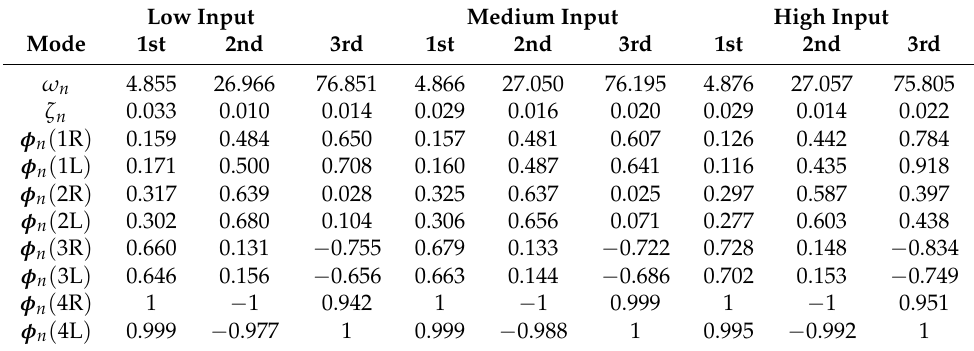
Table A2. Main spar: identified modal parameters.